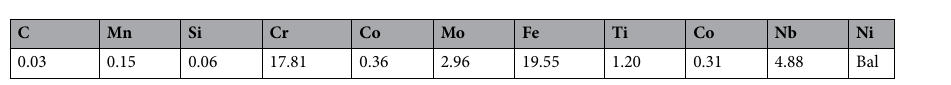
Table 1. Nominal chemical composition of Inconel 718 super-alloy (weight